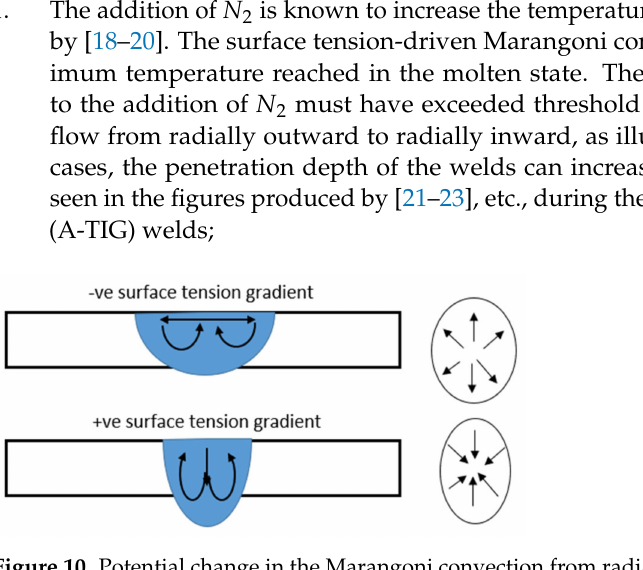
Figure 10. Potential change in the Marangoni convection from radially outward to radially inward in the presence of N 2 in the shielding